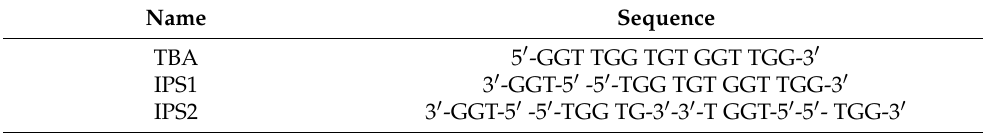
Table 2. Sequences of TBA and its IPS modified